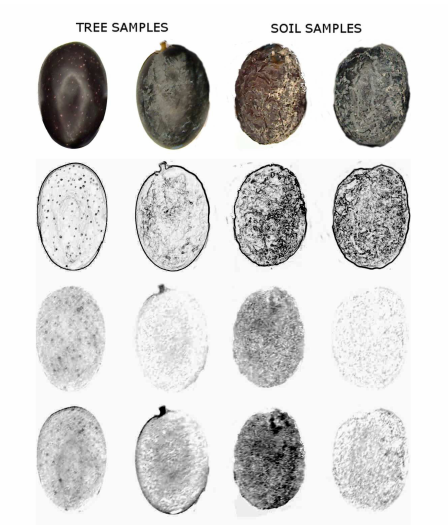
Figure 4. Olives coming from different locations and different image analyses. The first row shows the original image of the samples (RGB); the second row presents the result after applying the textural filter (I), and the third and fourth rows show the same samples where a brownish color has been detected ( C and C , rg rb